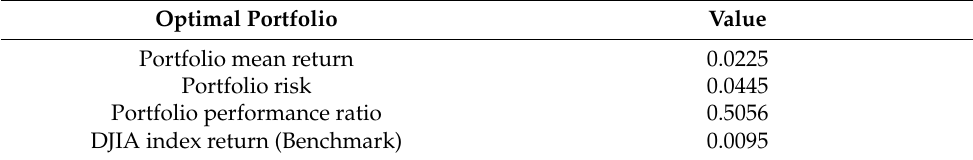
Table 11. Summary statistics and performance of the optimal MV